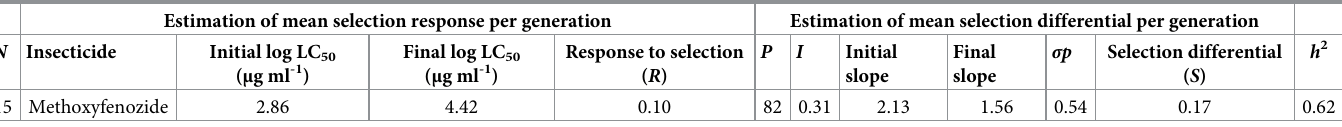
Table 2. Estimation of the realized heritability of resistance in Methox-SEL strain of Chrysoperla carnea . Estimation of mean selection response per